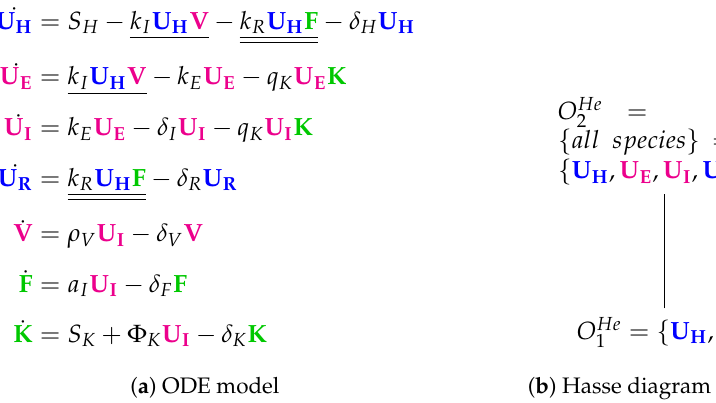
Figure 9. The Hernandez Model [26] with seven variables: healthy cells ( U H ), partially infected cell ( U E ), infected cells ( U I ), cells resistant to infection ( U R ), virus particles ( V ), interferon ( F ) and natural killers ( K